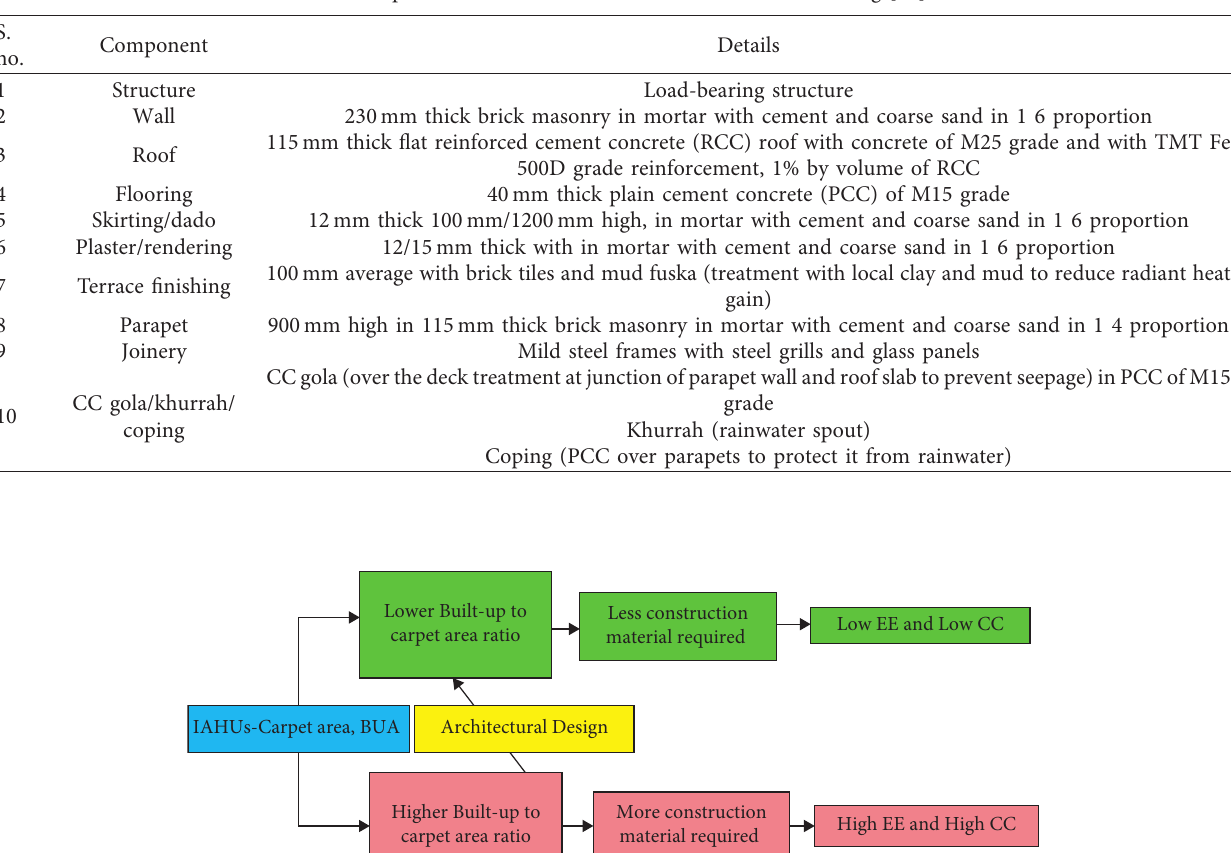
Table 1: Specifications of the chosen Indian affordable housing [44].